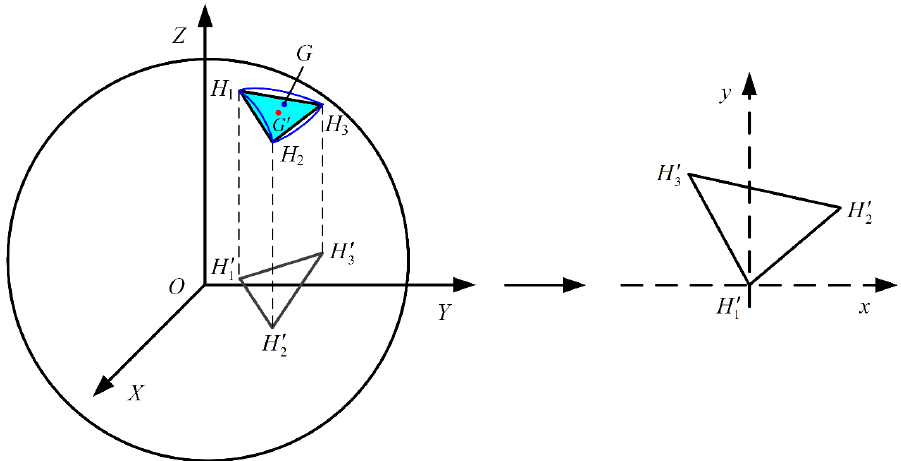
Figure 10. Schematic diagram of theoretical error description.